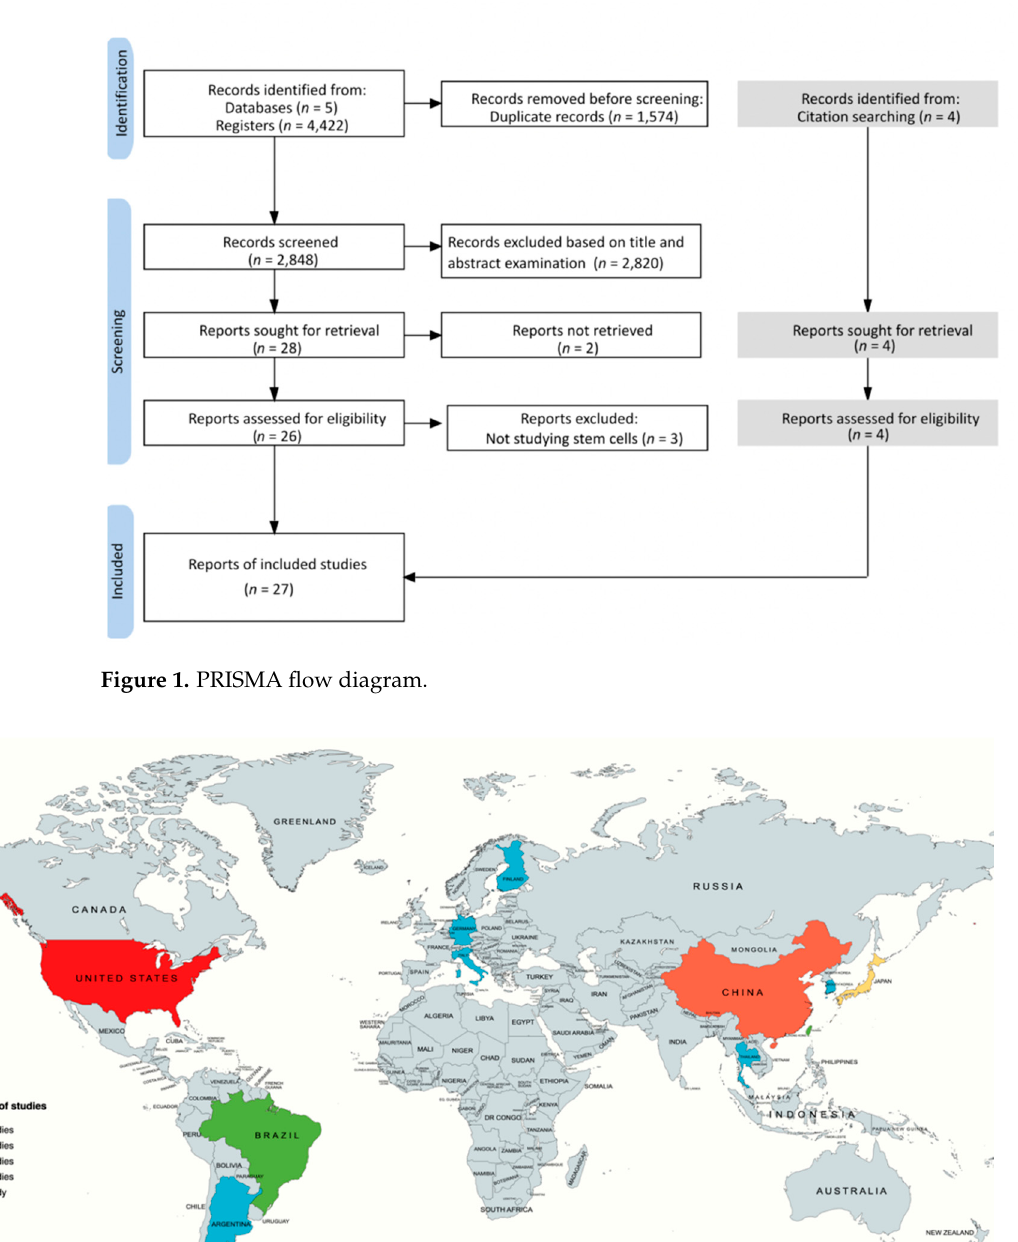
Table 2. Data extracted from included studies.